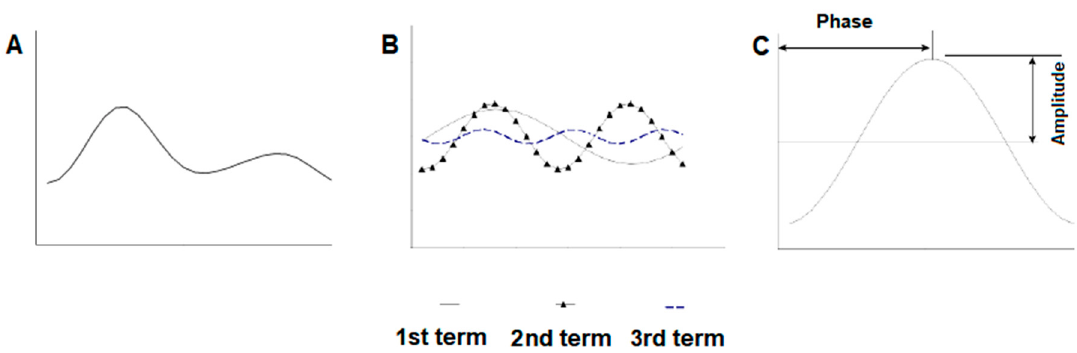
Figure 4. Modified from [73]. Example illustrating the Fourier analysis components in which a complex curve ( A ) is deconstructed into a set of simple cosine waves of different frequencies ( B ); each cosine wave is defined by its phase and amplitude ( C ).